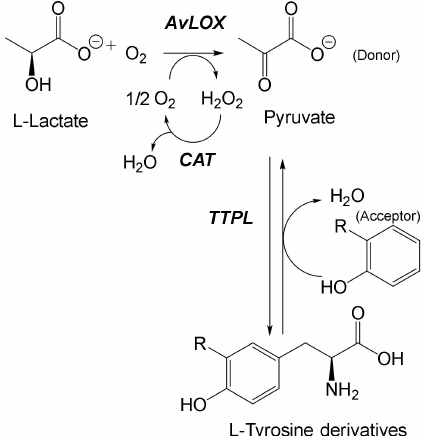
Figure 7. Enzymatic cascade synthesis of L-tyrosine